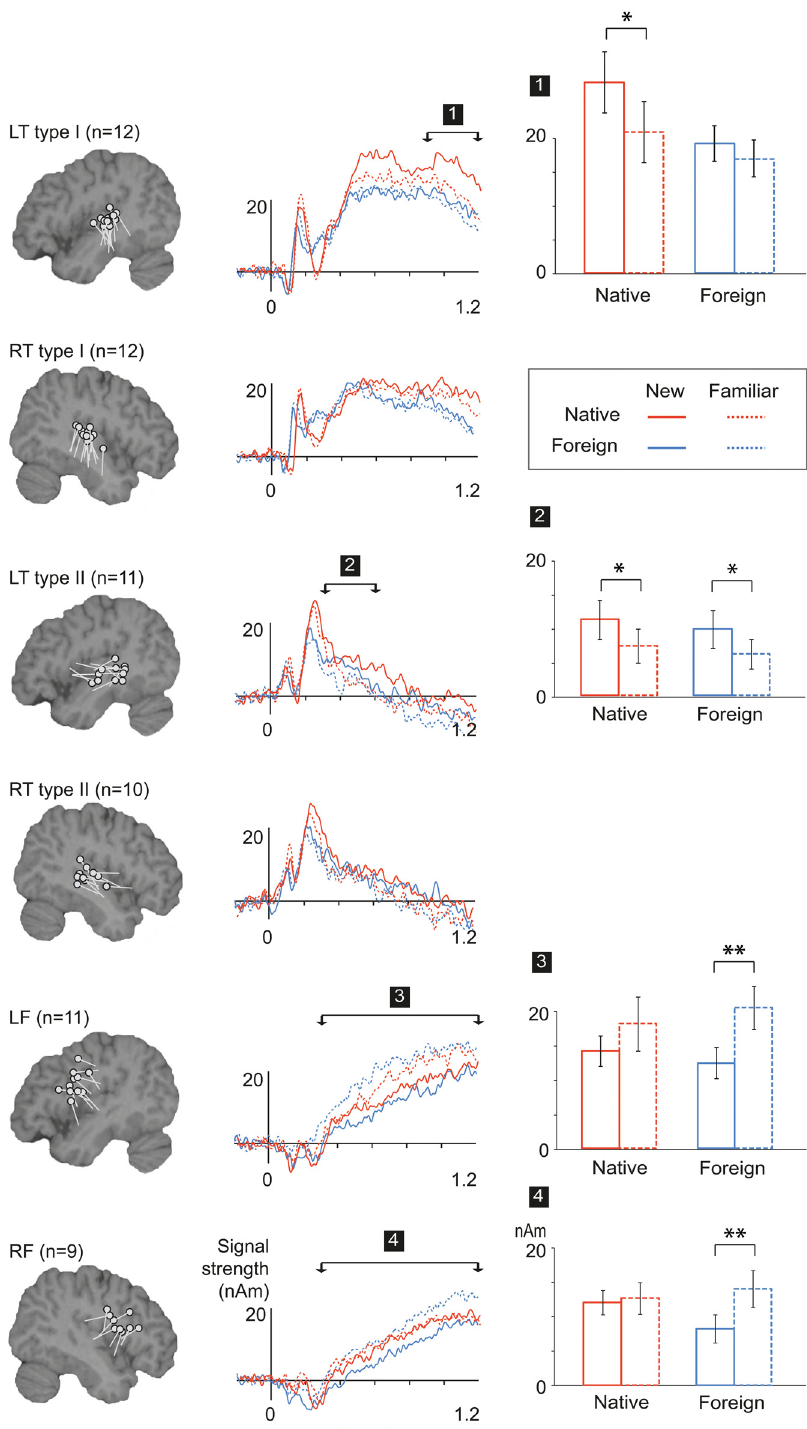
Fig 4. Group-level experimental effects in the learning phase. Left : Equivalent Current Dipole (ECD) clusters displayed on a sagittal plane of a standard brain. Each dot represents the center of an active cortical patch and the line attached to it the mean direction of current flow in that area, in one participant (LT = left temporal, RT = right temporal, LF = left frontal, RF = right frontal). Center : Grand average source waveforms for each ECD cluster, for new and familiar word forms in the native and foreign language. The arrows